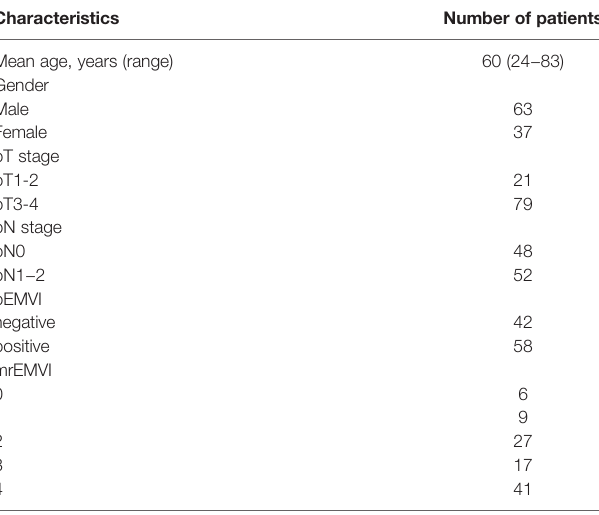
TABLE 1 | Characteristics of patients included in this